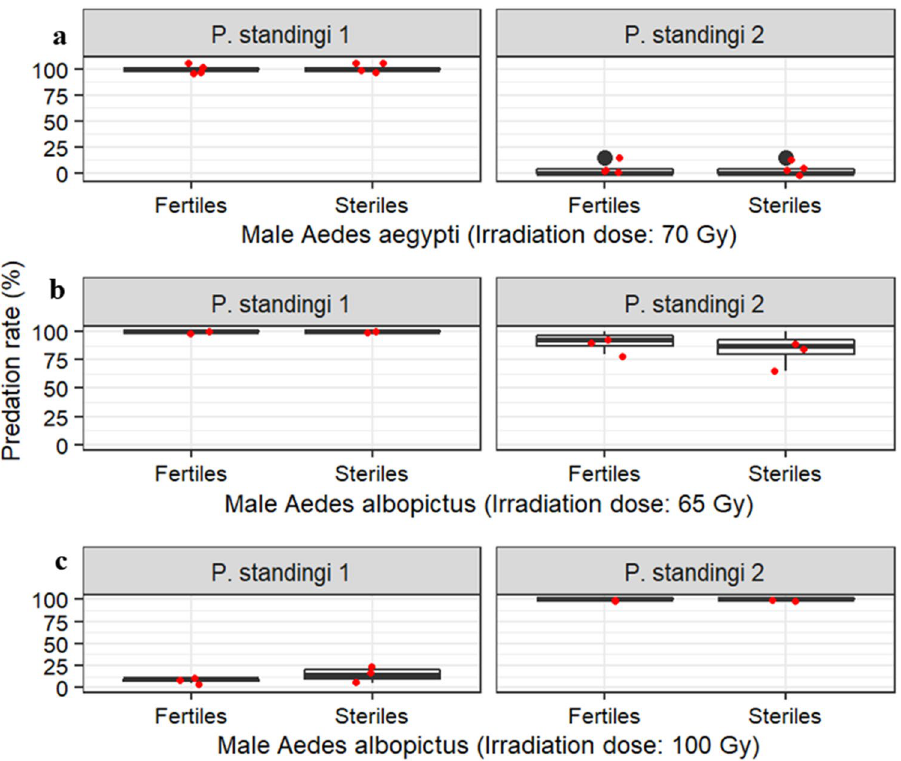
Figure 5. Vulnerability of fertile versus sterile male Aedes males to Phelsuma standingi predation. ( a ) Aedes aegypti with irradiation dose of 70 Gy; ( b ) Aedes albopictus with irradiation dose of 65 Gy; (c: Aedes albopictus with irradiation dose of 100